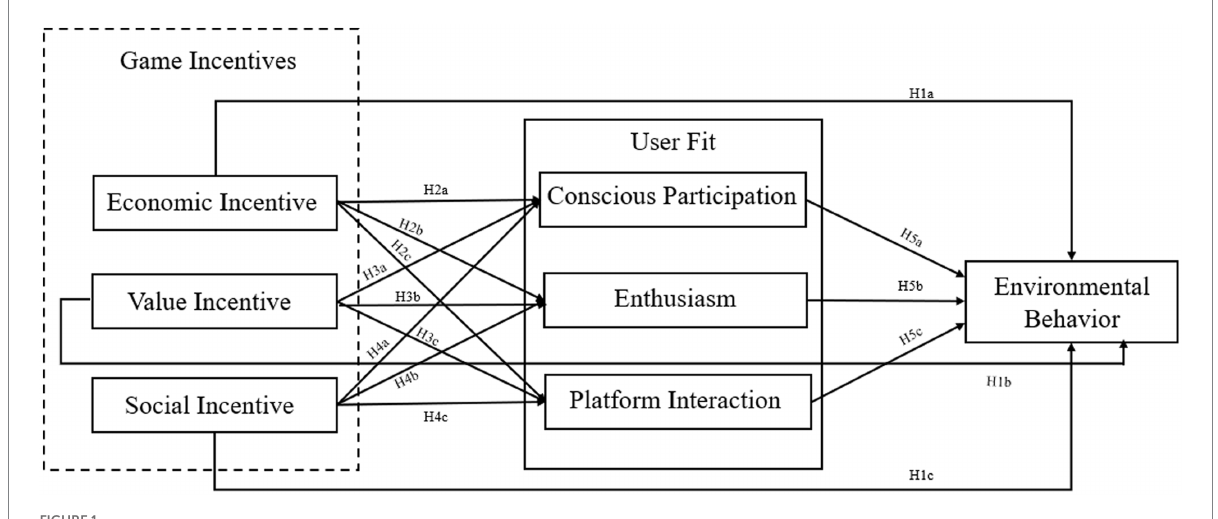
FIGURE 1 Research model